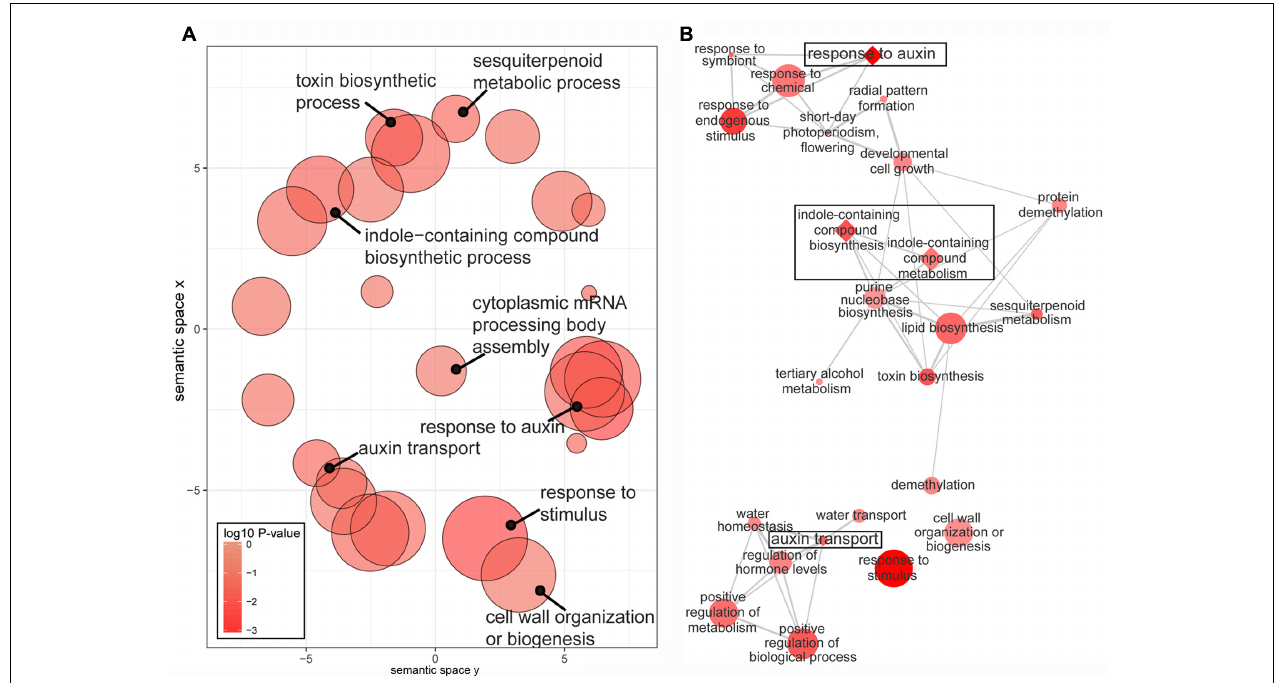
FIGURE 3 | Gene ontology (GO) enrichment analysis of 1290 DEGs. (A) Scatter plot of enriched GO terms under the ‘biological process’ category. (B) Interactive graph of the enriched GO terms. The P -values of the GO terms were lower than 0.05. Color intensity reflects the significance of enrichment, with darker colors representing lower P -values. Circle radiuses (symbol size) represent frequency of the GO term in the Gene Ontology Annotation database, and bubbles of more general terms are larger. More similar nodes are positioned closer and linked by edges in the interactive graph, where the line width indicates the degree of similarity. Auxin-related GO terms are diamond shaped in the interactive